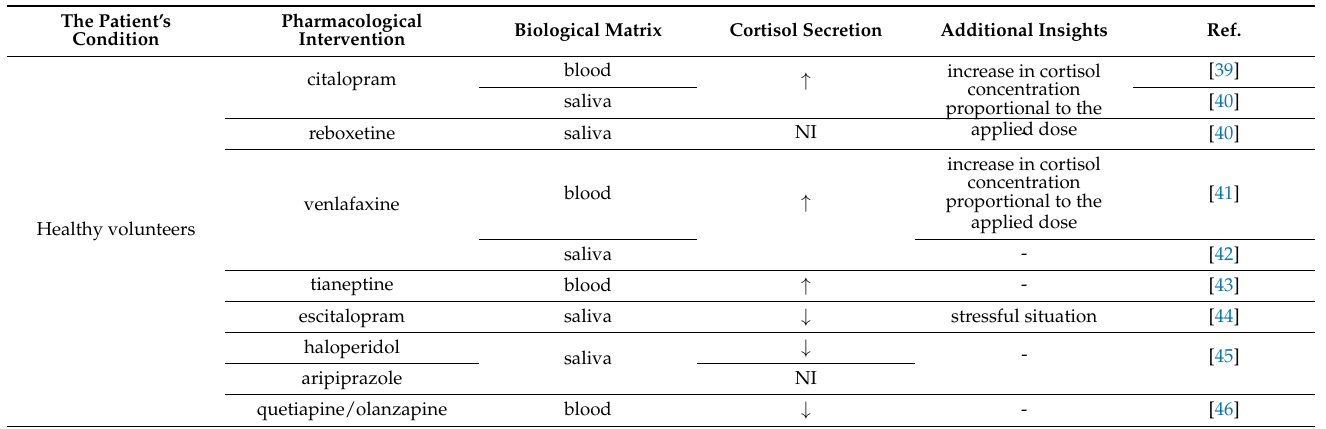
Table 2. Effect of the applied therapy on the cortisol